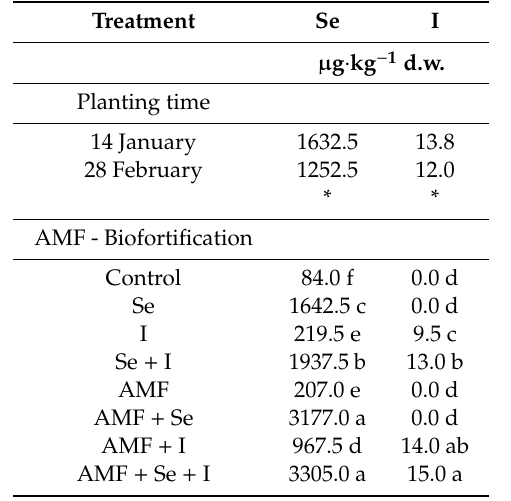
Table 4. Se and I content in chickpea seeds, as a ff ected by planting time and AMF - biofortification.